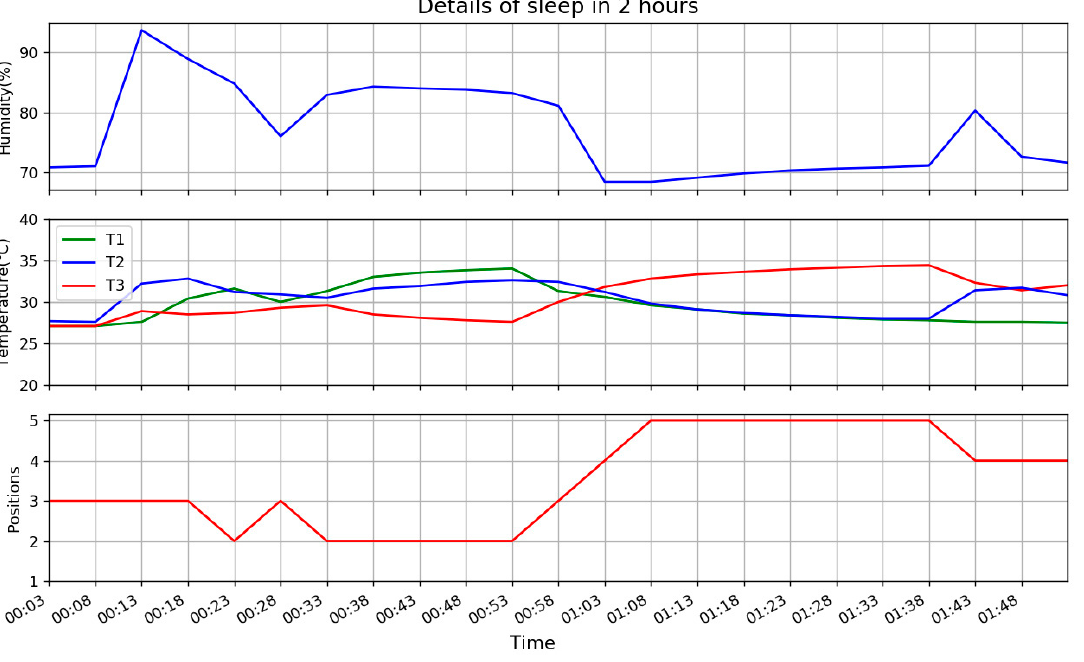
Figure 13. Extraction of body temperature data.